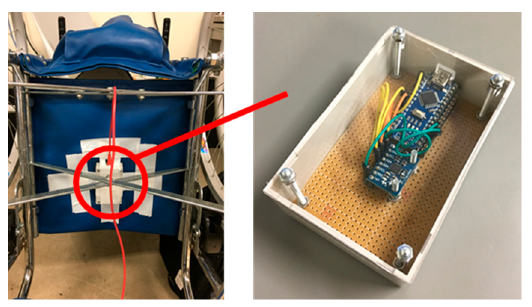
Figure 3. 6-axis sensor.